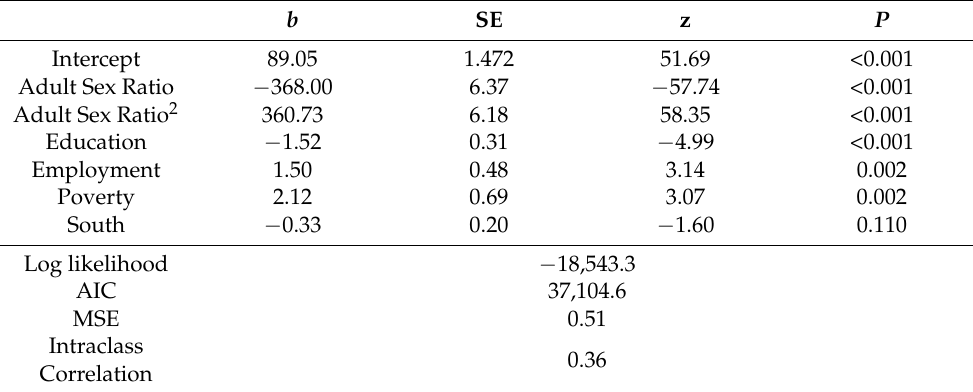
Table 2. Multilevel negative binomial regression model predicting the sex offense